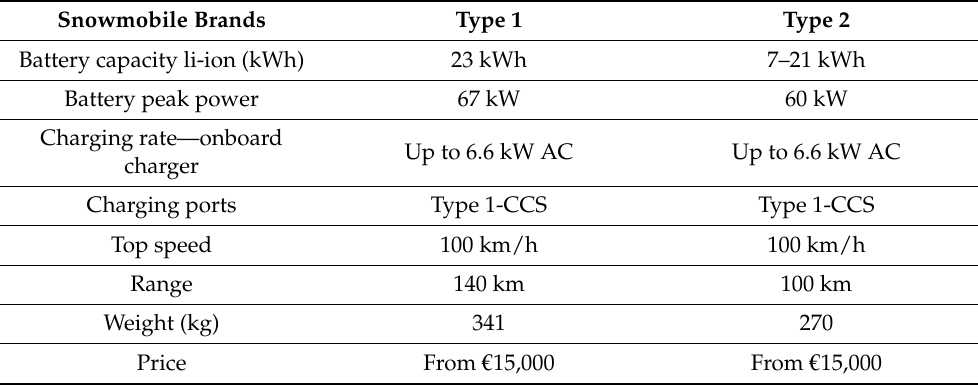
Table 2. Types of electric snowmobiles considered relevant for the provision of